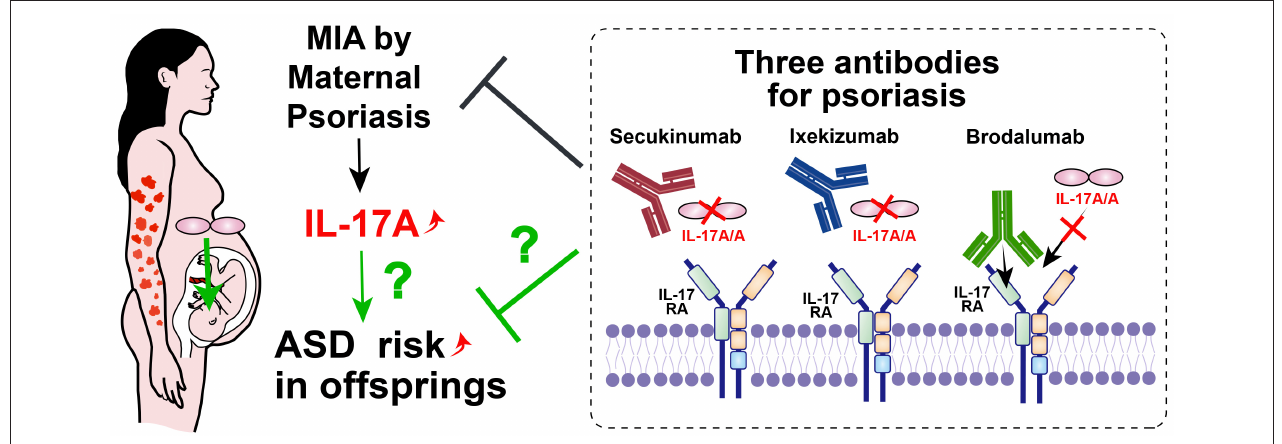
FIGURE 3 | Possible ASD prevention method by modulating MIA with IL-17 related antibodies. Maternal psoriasis is one of the risk factors for offspring ASD. Three available antibodies against IL-17A or IL-17RA for psoriasis, psoriatic arthritis and ankylosing spondylitis could potentially be used for maternal patients. If the risk of ASD was reduced by clinical studies with these antibodies, the direct relationship between MIA and ASD through IL-17 signaling will clearly be